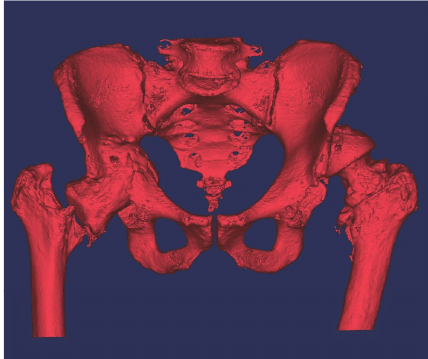
Figure 5: Segmenting the femur from the acetabulum using Materialise MIMICS 14.12.